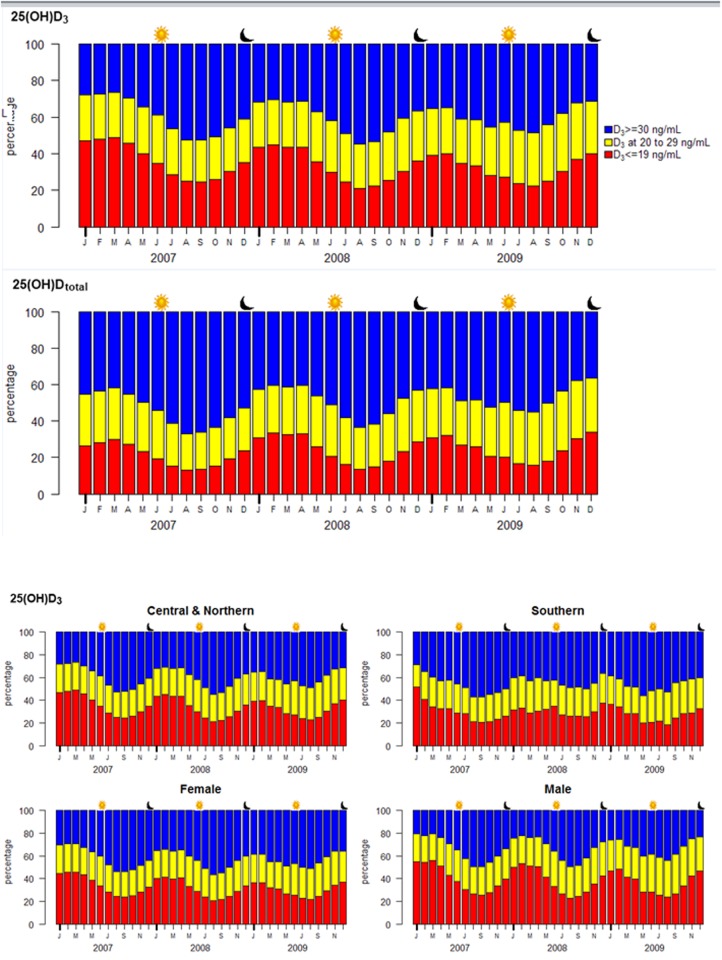
Percentages of patients with 25(OH)D3 deficiency (<20 ng/mL), insufficiency (20–29 ng/mL), and sufficiency (≥30 ng/mL), by month.The percentiles are categorized by month. The upper portion (blue) of each month shows the percentage of patients with sufficient 25(OH)D3; the central portion (yellow), insufficient but not deficient; and the lower portion (red), deficient. The percentage of patients considered deficient or insufficient depends on the season, lower in summer (approximately 50%) and higher in winter (approximately 70%). The sun symbol indicates the summer solstice and the crescent moon symbol, the winter solstice. The central panel shows the seasonal similarity of total 25(OH)D with that of 25(OH)D2. The lower panel shows the rhythmic pattern across regions and gender. The Central and Northern regions were combined because they were similar. Their trough to peak difference is greater than that for the Southern region. Women and men percentages show similar patterns, except that the trough to peak difference is greater for men than women. The sun symbol indicates the summer solstice and the crescent moon, the winter solstice.